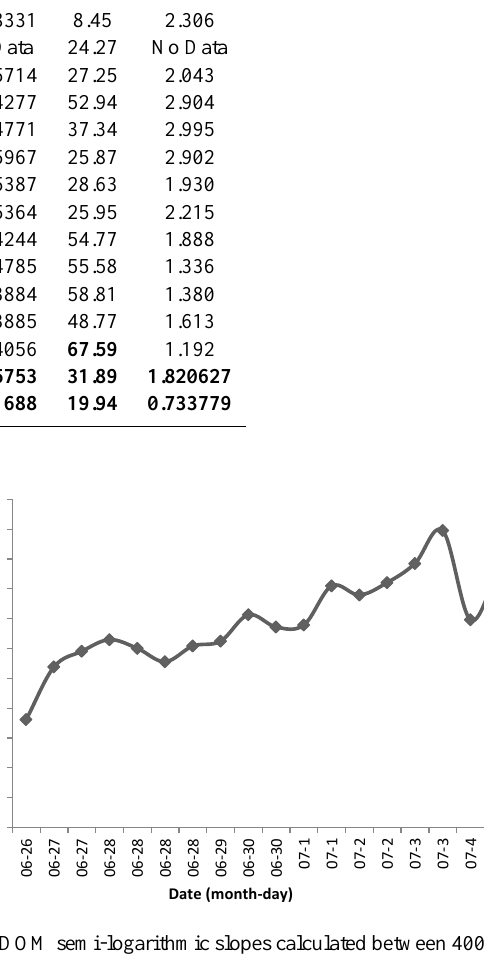
up chlorophyll a and all of its degradation products. On av- erage the degradation products added 33 % (min 15 %, max 50 %) to the total chlorophyll concentration. Relatively high concentrations of fucoxanthin and chlorophyll b indicate that the majority of the species in the Lena River were composed of green algae (Chlorophyta) and diatoms (Bacillariophyta). This was confirmed by the measurements in situ using the BBE multialgal-fluorescence